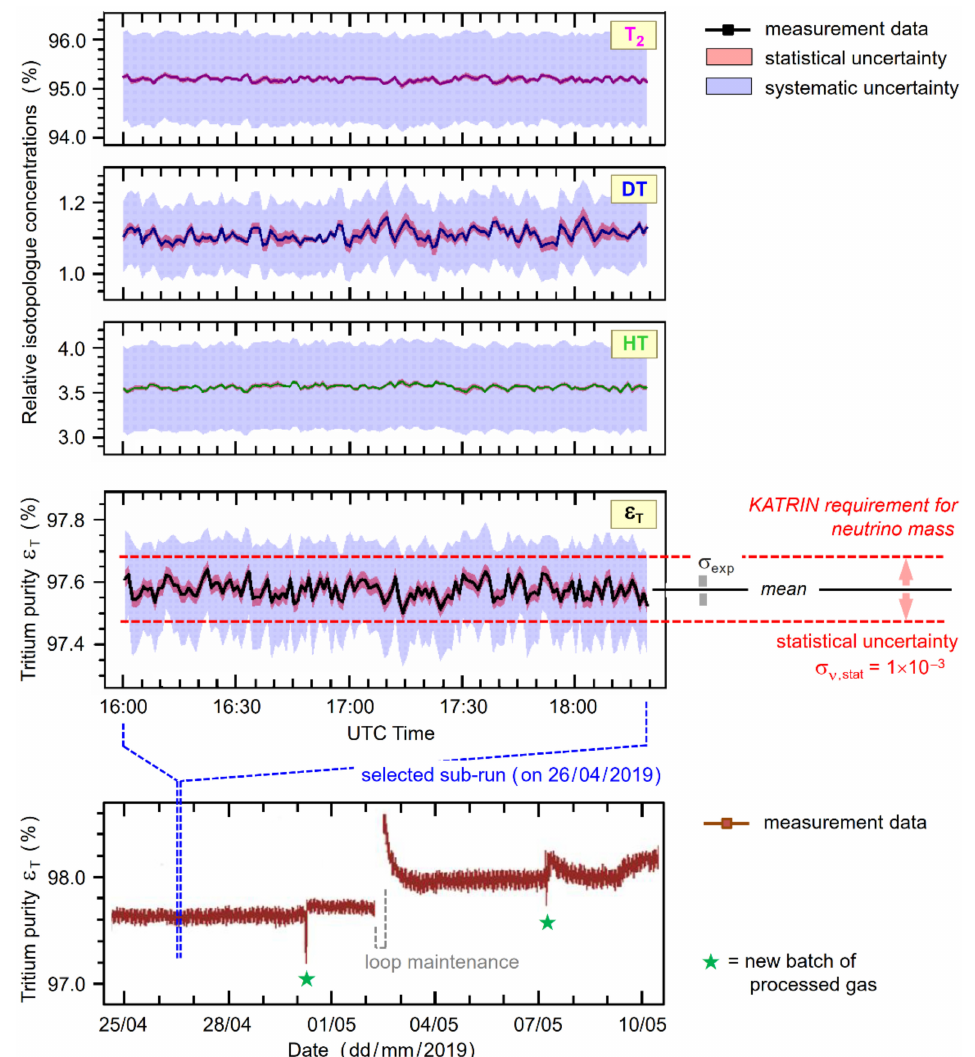
Figure 7. Selected measurement data from KATRIN LARA during KNM1 (April—May 2019). Top panels—concentrations of the three tritiated isotopologues T 2 , DT, and HT (in percent of the sum of all molecular gas components); the statistical and systematic uncertainties are indicated by the colored bands. Bottom panels—derived tritium purity ε T for a two-week period during KNM1 (lower data trace) and an individual sub-run (upper data trace); for the latter the statistical and systematic uncertainties are indicated by the colored bands. The statistical uncertainty limit, required for the KATRIN neutrino mass calculation, is indicated on the right. For further details, see